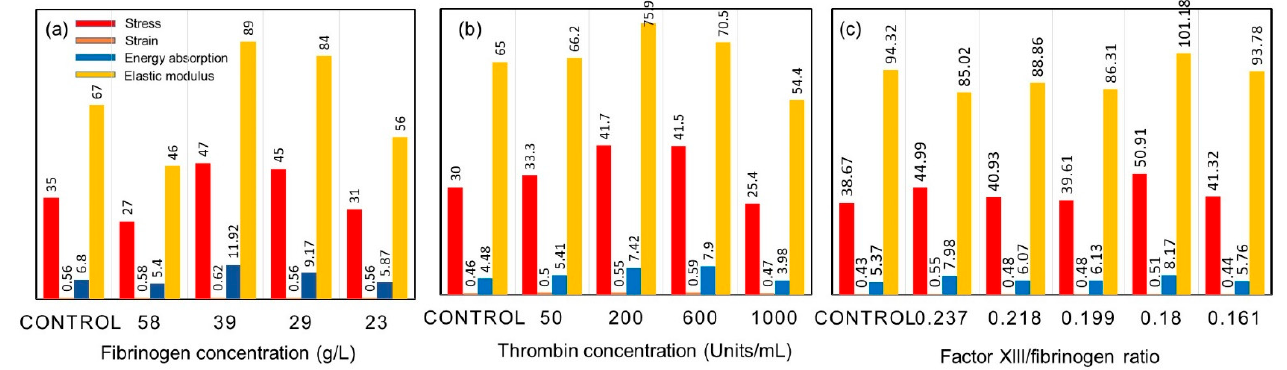
Figure 3. ( a ) Results of mechanical testing when the fibrinogen concentration of the glue is